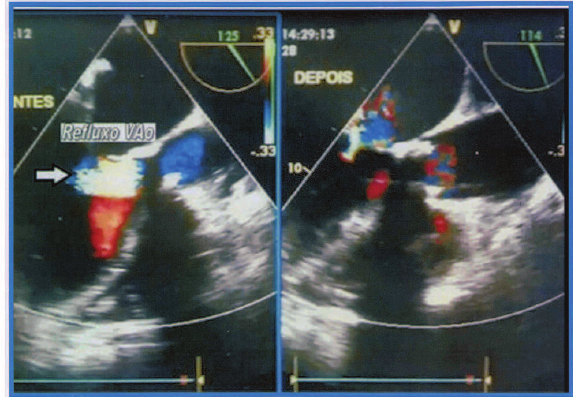
Fig. 1 - Imagem realizada pelo ecocardiograma trasesofágico demonstrando a presença de refluxo valvar aórtico no pré- operatório e a ausência deste na imagem realizada após o implante da valva aórtica transcateter por via transfemoral